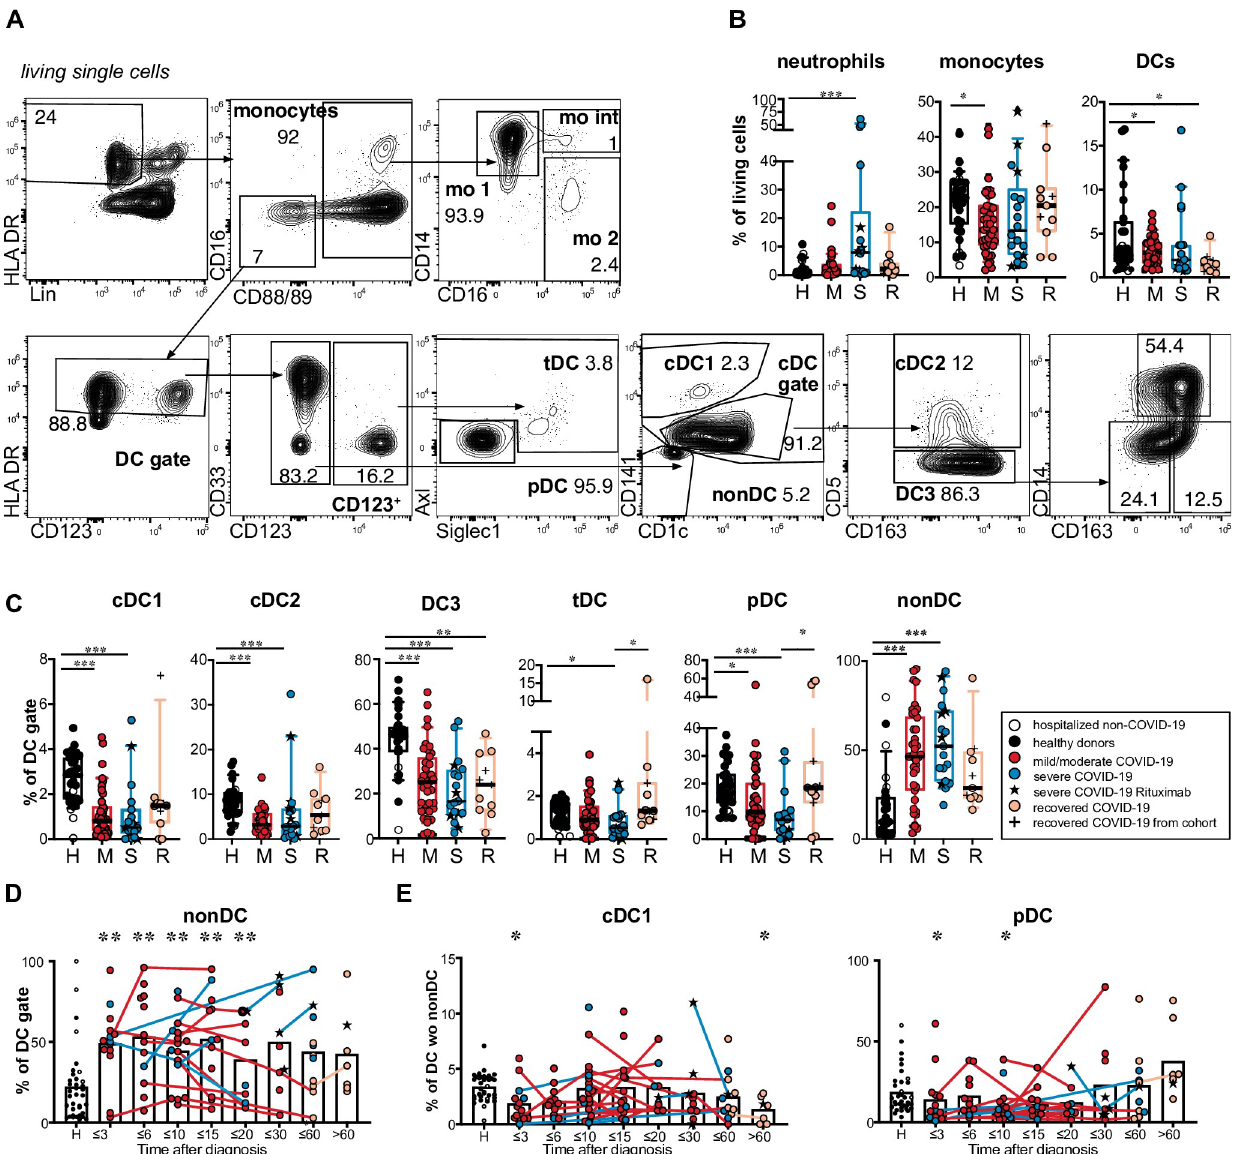
Fig 2. Reduction of DC subpopulations and expansion of immature HLADR + cells in COVID-19 patients. (A) Gating strategy for DC and monocyte subtypes in the blood: Within HLADR + Lineage (CD3, CD15, CD19, CD20, CD56, CD66b) negative (Lin – ) cells monocytes were gated as CD88/89 positive cells and separated into mo 1 (CD14 + CD16 – classical monocytes, mo int (CD14 + CD16 + intermediate monocytes, mo 2 (CD14 lo CD16 + non- classical monocytes). HLADR + Lin − CD88/89 – CD16 – cells were regated on HLADR positive cells (DC gate). Within the CD123 + DC fraction pDCs (Siglec1 – Axl – ) and tDCs (Axl + and/or Siglec1 + ) were distinguished. Within the CD123 – DC fraction cDC1 (CD141+ CD1c lo ), cDC2 (CD141 – , CD1c + , CD5 + ), DC3 (CD141 – CD1c+ CD5 – DCs) and “non-DC” (CD141 – CD1c – ) were identified. DC3 were further separated into CD163 – CD14 – , CD163 + CD14 – and CD163 + CD14 + DC3 subsets. (B) Percentage of neutrophils (Lin + CD88/89 + CD16 + ), monocytes (Lin – , HLADR + , CD88/CD89 + ) and DCs (Lin – , HLADR + , CD88/CD89 – ) of living PBMC. Healthy donors (= H, black symbols, n = 28), hospitalized COVID-19 negative patients (= white symbols, n = 4), acute COVID-19 patients with mild/moderate (= M, red symbols, n = 39), severe (= S, blue symbols, n = 18) disease at the first analysis timepoint and recovered patients (orange, n = 11). In the severe group, patients that had received B cell-depleting therapy before diagnosis (n = 5) are marked by a black star. Recovered patients that had already been analyzed during acute disease and were sampled again after recovery are indicated by a plus sign. (C) Relative frequencies of DC subsets and non-DCs within the DC gate are shown (Kruskal-Wallis test with Dunn’s correction, n = 97–100). (D) Frequency of non-DCs within the DC gate at different grouped time points after diagnosis. (E) Frequency of cDC1 and pDCs within the differentiated DC population (after excluding CD141 – CD1c – non-DCs) at different grouped time points after diagnosis. (D and E) Connected lines represent multiple measurements of the same patient at different time points. Columns indicate the mean. Colors and symbols as in C. Comparison of the indicated time points with the healthy control group (Kruskal-Wallis test with Dunn’s correction, n = 124–127). Statistical significance in B, C, D, E is indicated by � p < 0.05, �� p > 0.01, ��� p <